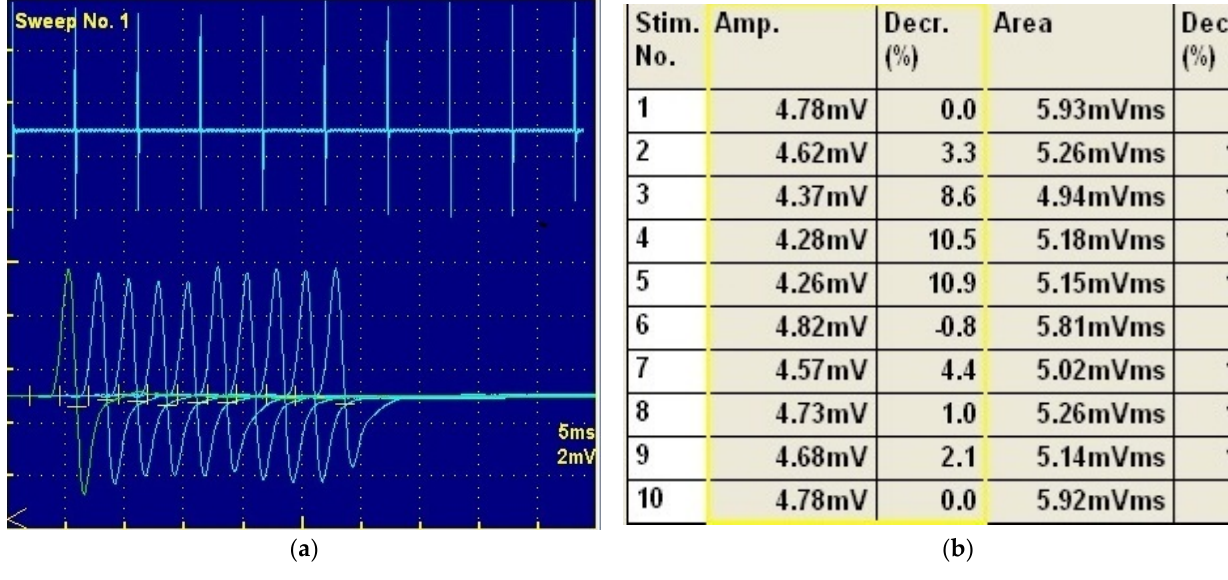
Figure 2. (a) Repetitive nerve stimulation test and the fatigability of the synaptic transmission. ( b ) There is an obvious 10% reduction in the amplitudes of the fourth compound muscle action potential compared to the first.